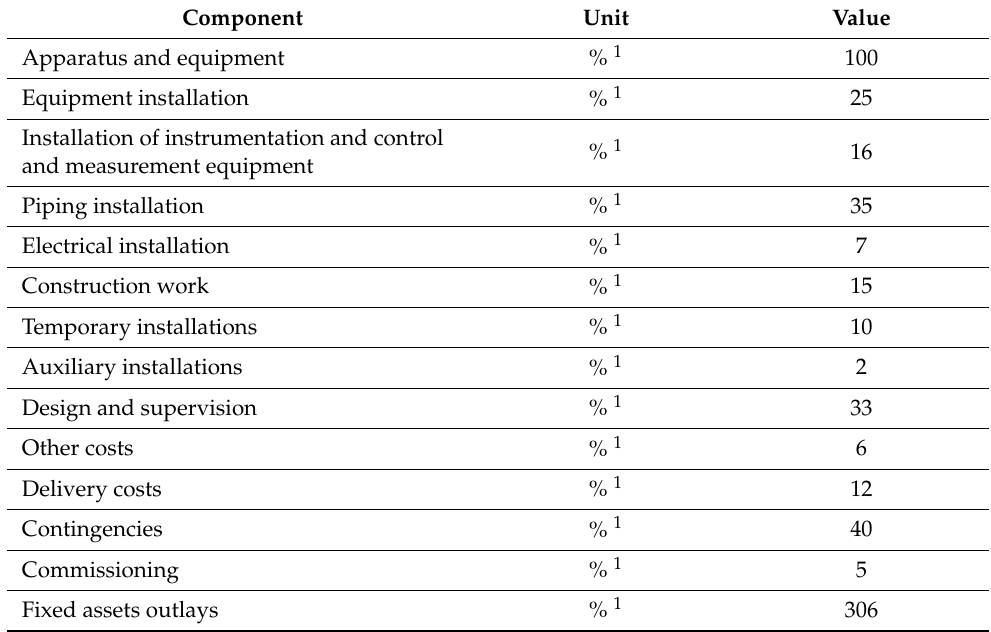
Table 7. Summary of the indicators for the estimated sub-costs and total investment